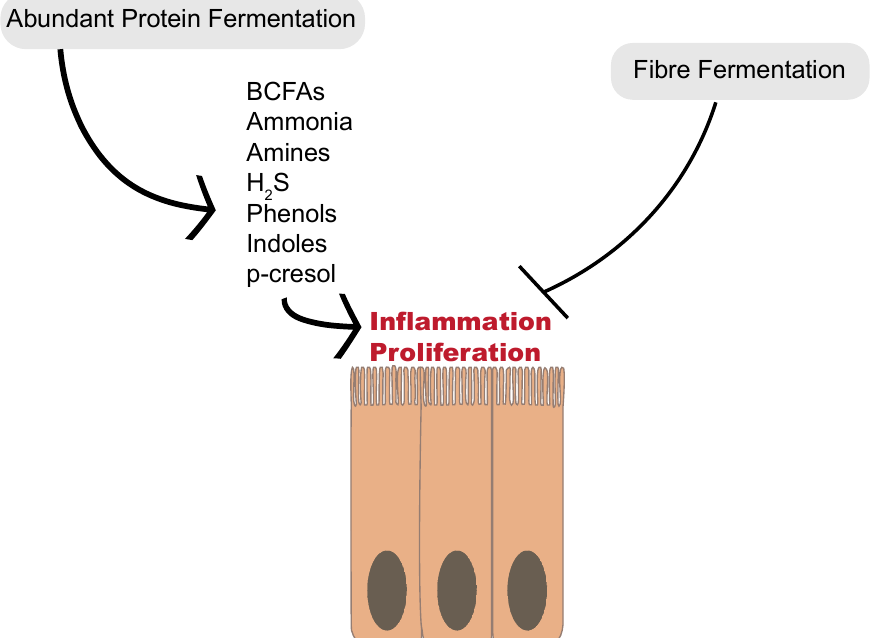
Figure 2. Abundant proteolytic fermentation generates a multitude of compounds that may cause the inflammation and proliferation of colonocytes, and in turn, colorectal cancer. Increased fiber fermentation and short-chain fatty acid production appears to be protective against colorectal polyp development, even when protein fermentation products are abundant.